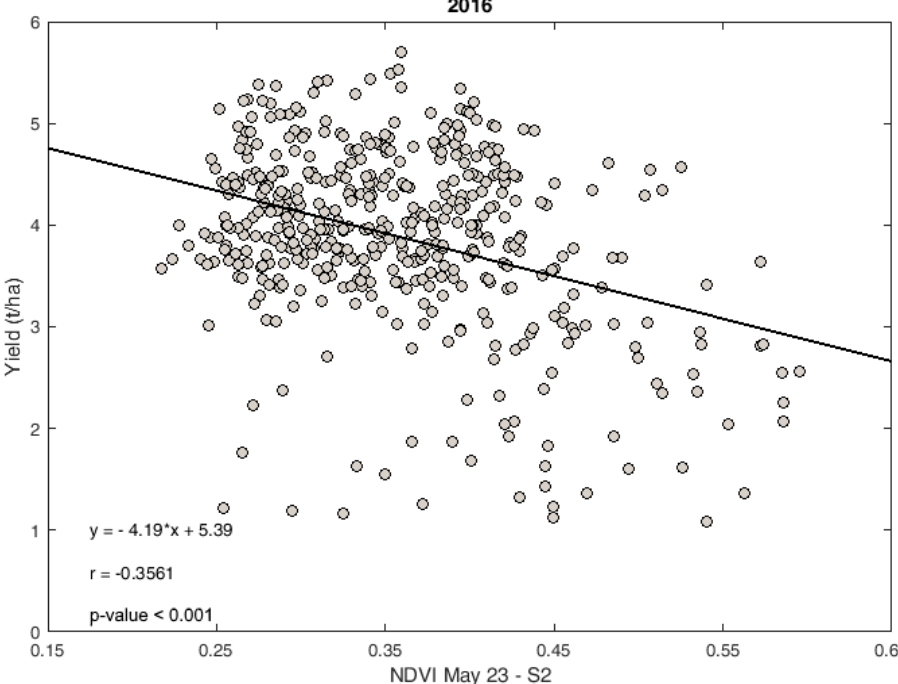
Figure 7. Relationship between observed yield (yield monitor) and NDVI (Sentinel-2) for 2015–2016 crop season.